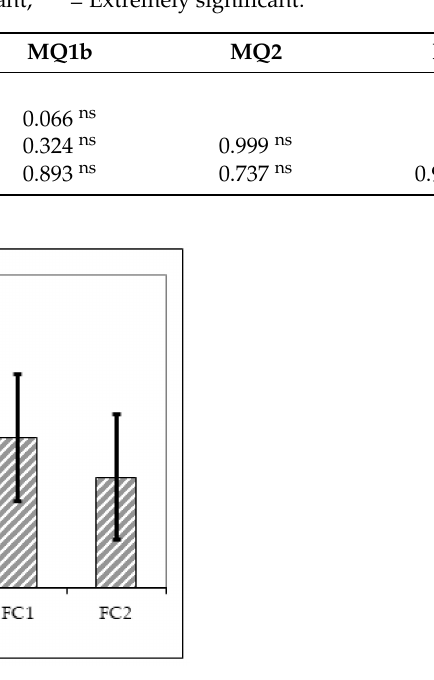
Figure 8. Mean Change Index values and 95% confidence intervals for the different communities in